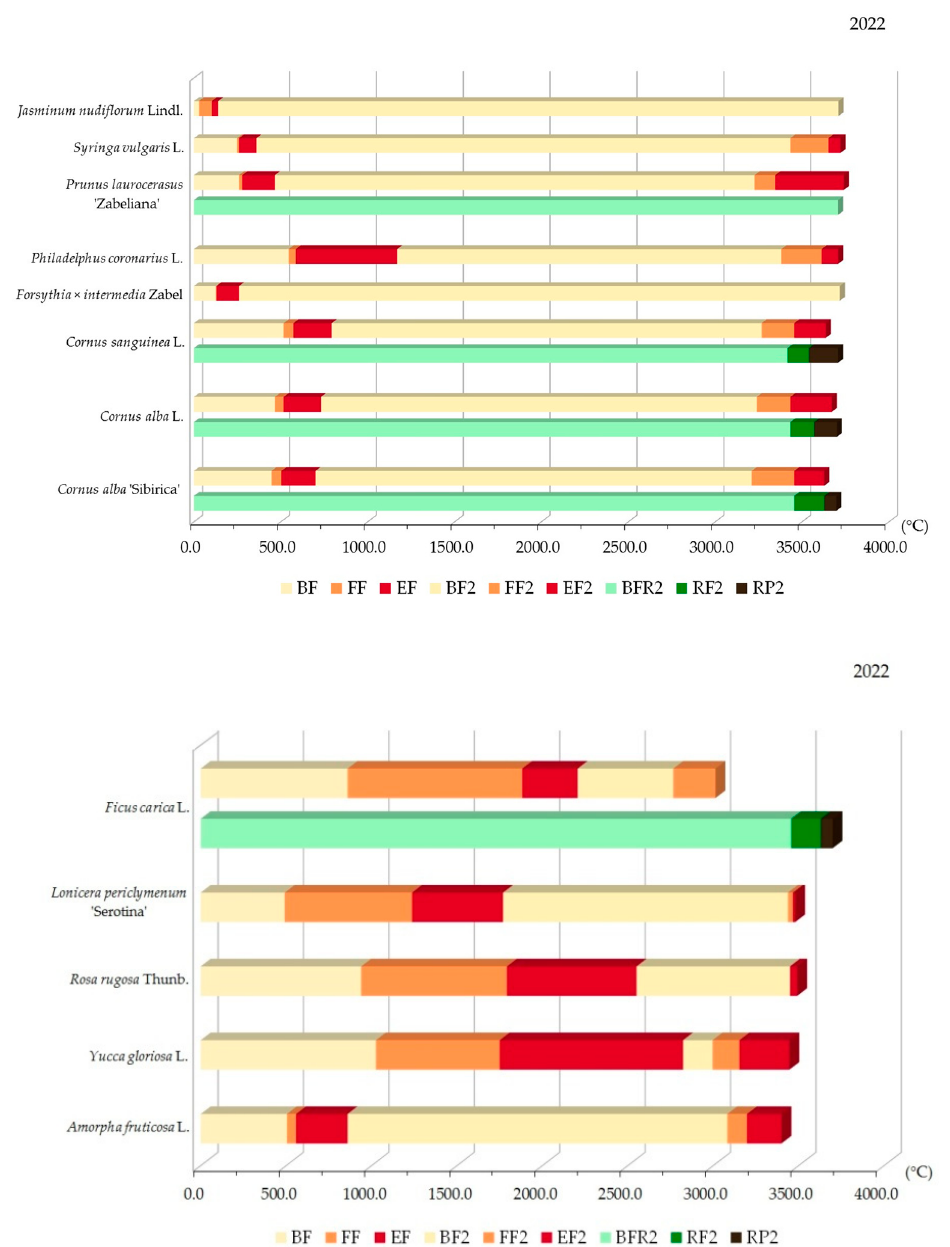
Figure 7. Phenological observations: periods and GDD (temperature sums) ( ◦ C) for the beginning of first flowering (BF), full first flowering (FF), the end of first flowering (EF), the beginning of second flowering (BF2), full second flowering (FF2), the end of second flowering (EF2), the beginning of third flowering (BF3), full third flowering (FF3), BFR2 (beginning of second fruit formation), RF2 (second appearance of first ripe fruits), and RP2 (second fruit ripening) for 13 woody taxa based on data from the Belgrade (top) and Sur č in (bottom) stations for 2022.